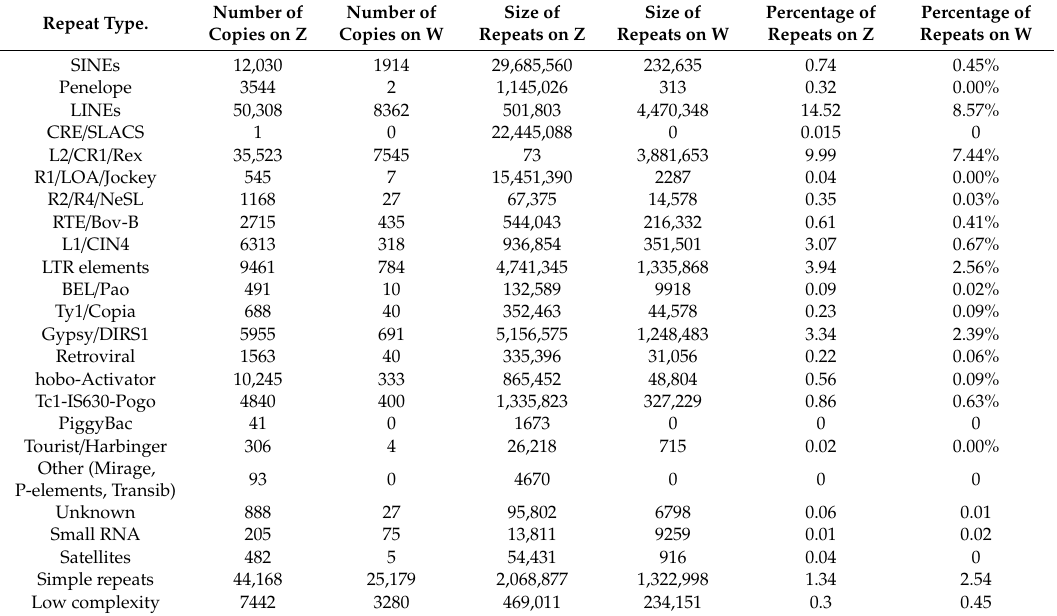
green arrow, is evident. The Y -axis percentage di ff erence and a recent wave of expansion on the Z chromosome are evident. ( c ) Comparative analysis of Z and W localized repeat contents. Each column represents the copy number percentage stacked for the repeated element. Di ff erent proportions for Z and W sex chromosomes are indicated in blue and red, respectively. Elements with higher proportions (in blue) show expansion; those TEs present exclusively on Z chromosomes, and absent on W chromosomes are highlighted in blue text on the X -axis. Table 1. Comparative list of repeat contents localized on the Indian cobra Z and W sex chromosomes and the relative abundance of each identified element. Note: For certain TEs (PiggyBac and Mirage, P -element), the percentage was considered negligible and rounded to 0 (less than 0.01%). Number of Number of Size of Size of Percentage of Percentage of Repeat Type. Copies on Z Copies on W Repeats on Z Repeats on W Repeats on Z Repeats on W SINEs 12,030